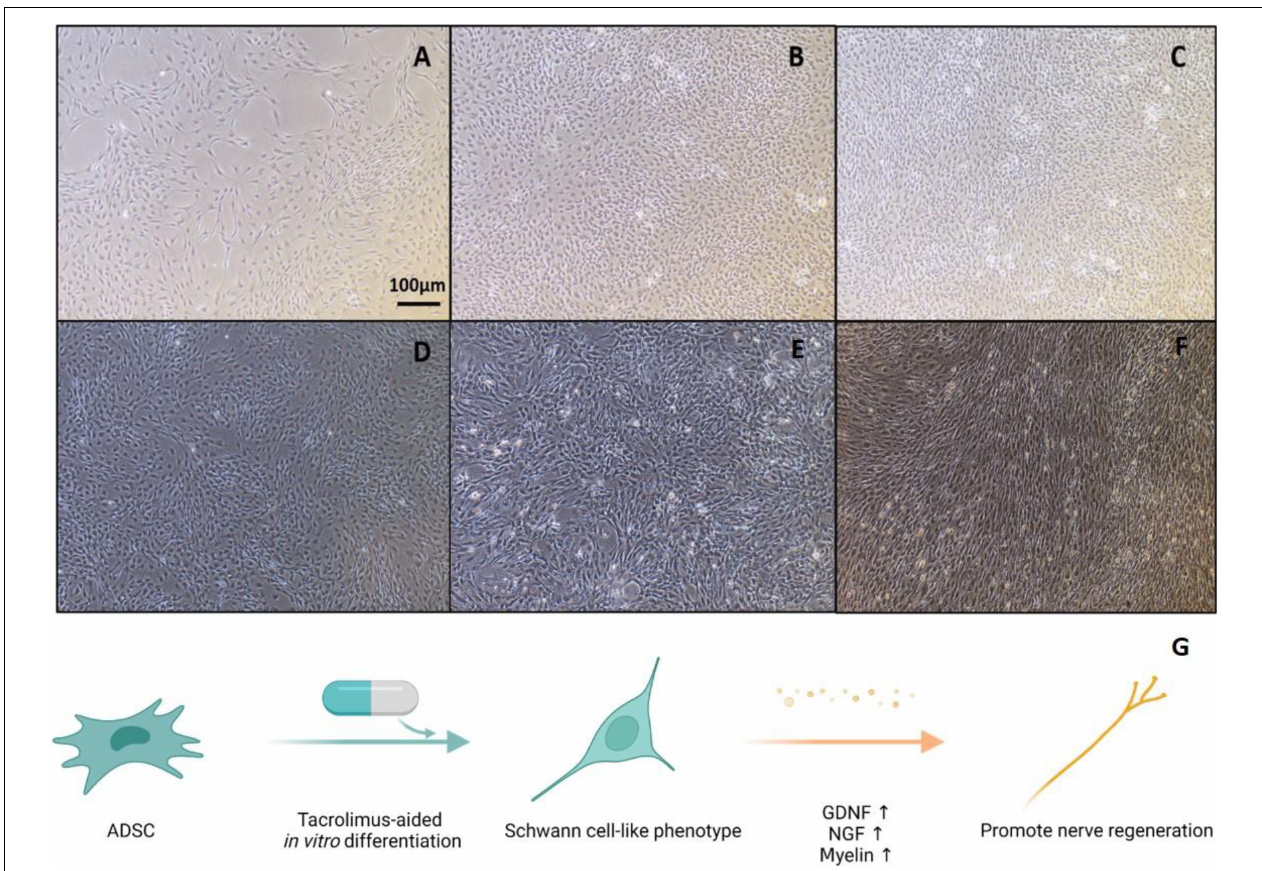
FIGURE 1 | Representative graphs of undifferentiated ADSCs and Schwann-cell like ADSCs. (A) Cultures of undifferentiated ADSCs showed a fibroblast-like morphology. (B) Differentiated ADSCs adopted a spindle elongated SC-like shape. (C–F) In the treatment of 1, 10, 100, and 1000 ng/mL FK506, ADSCs did not exhibit evident morphological changes compared with non-treated ADSCs. Scale bar = 100 µ m. (G) Schematic illustration of experimental design. ADSCs were first cultured in SC culture medium for 18 days and subjected to FK506 stimulation in the last 3 days of this differentiation